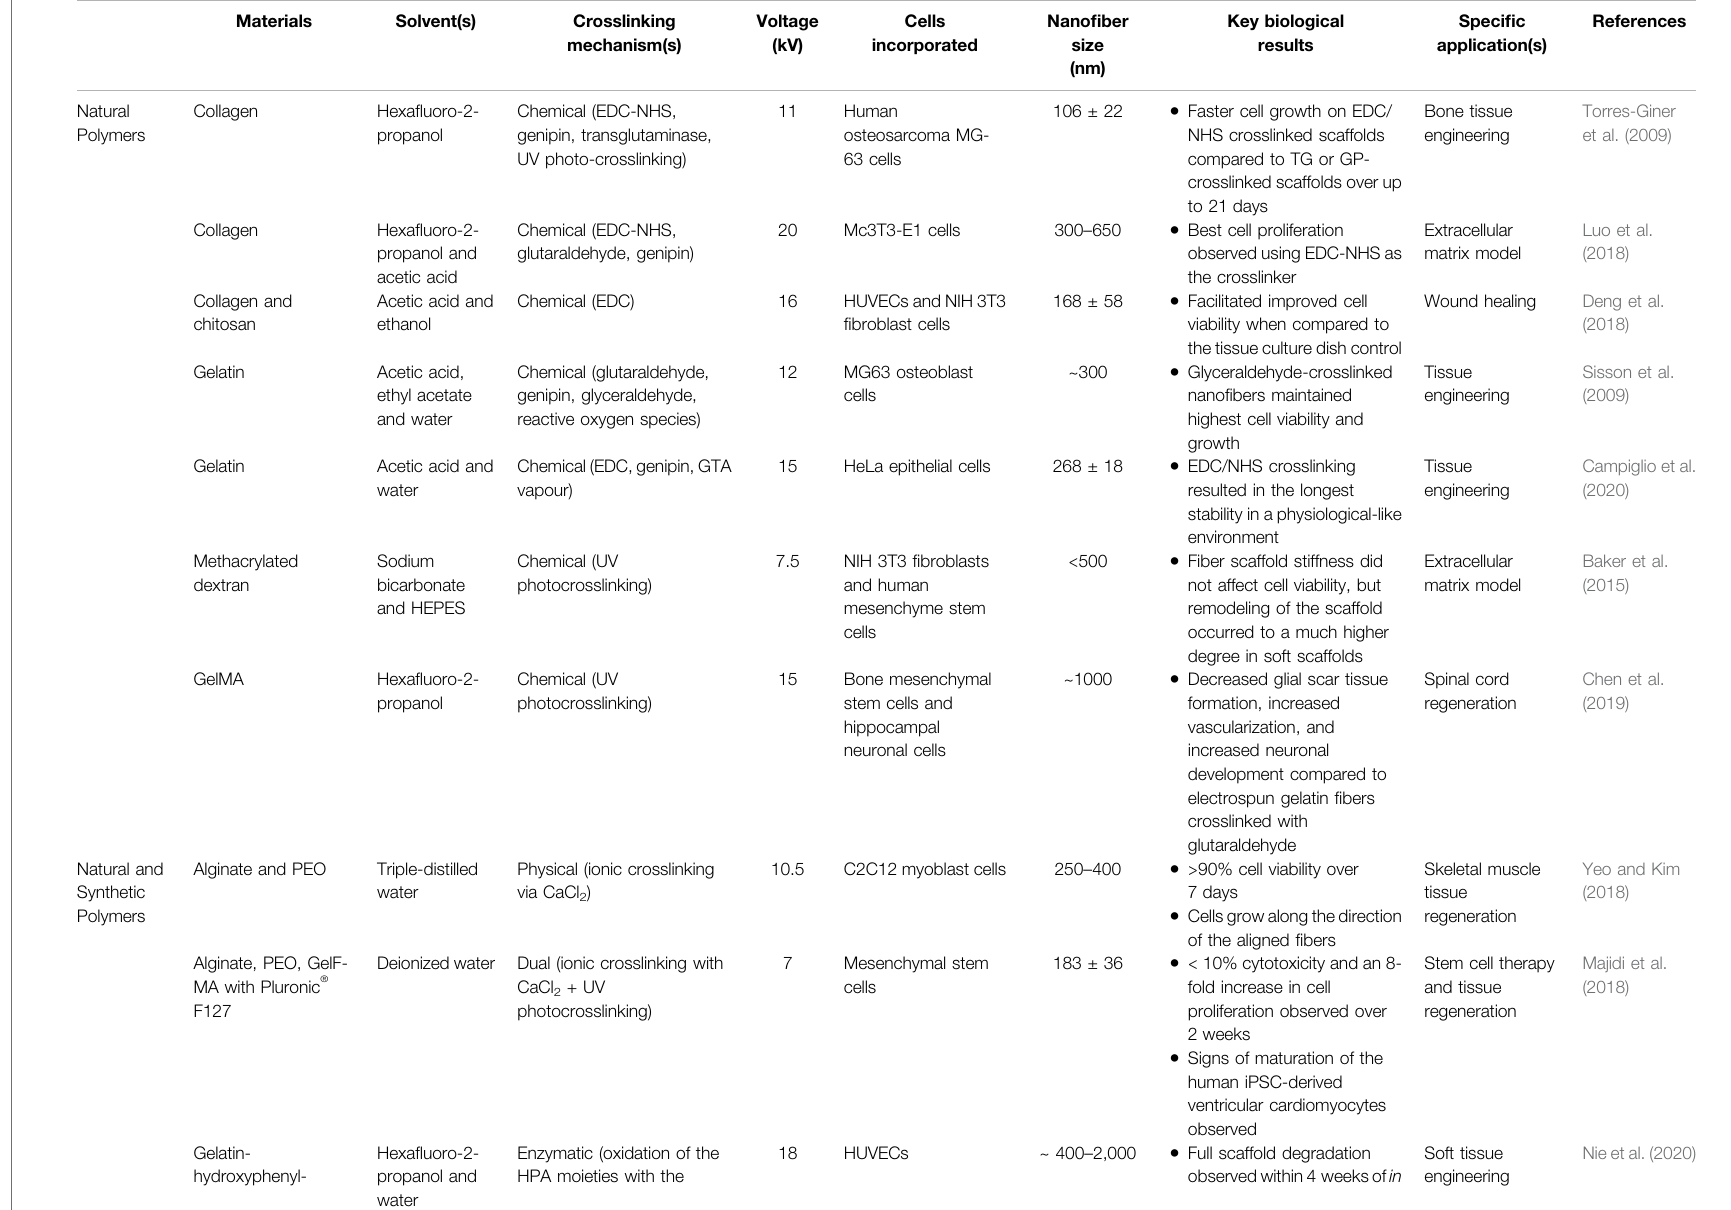
TABLE 1 | Materials and methods used for electrospinning hydrogels for tissue